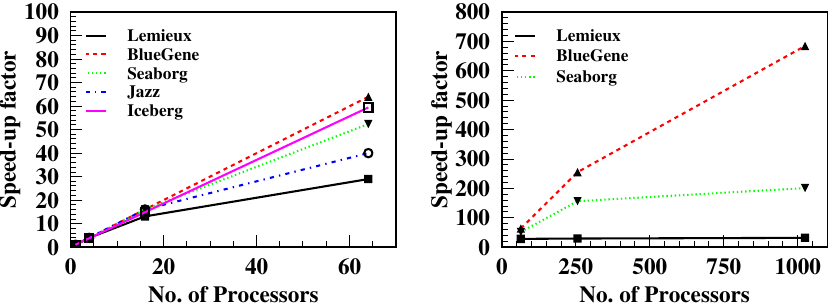
FIG. 6. (Color) Performance test results of the parallel Poisson solver (based on the 2D model) on different Platforms. The left plot shows the speedup factor up to 64 processors on 5 machines and the right one shows the speedup factor up to 1024 processors on 3 machines.